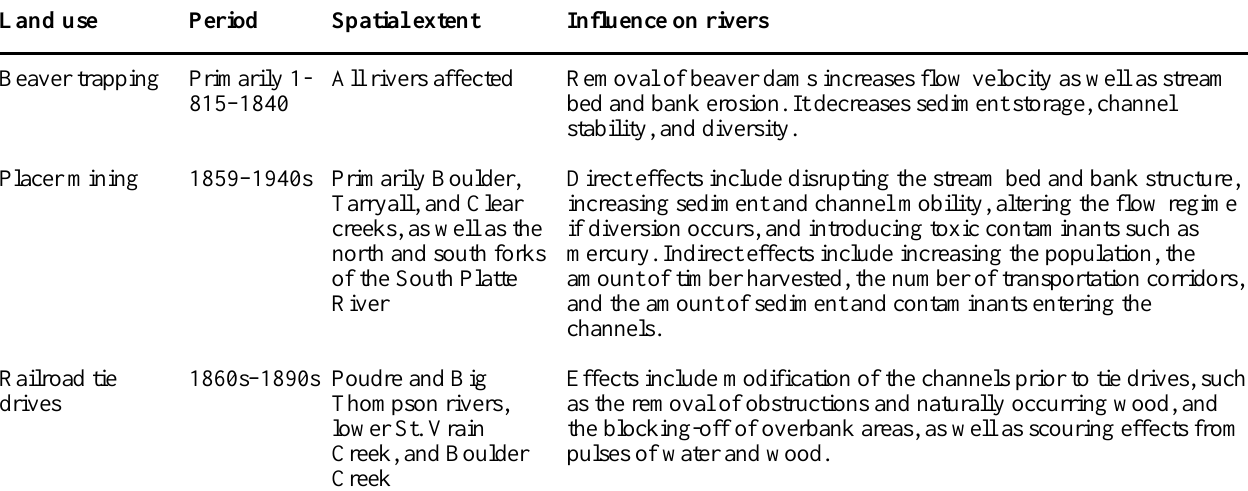
Table 1 . Chronology of historical and continuing land uses that affect rivers in the Colorado Front Range (Wohl